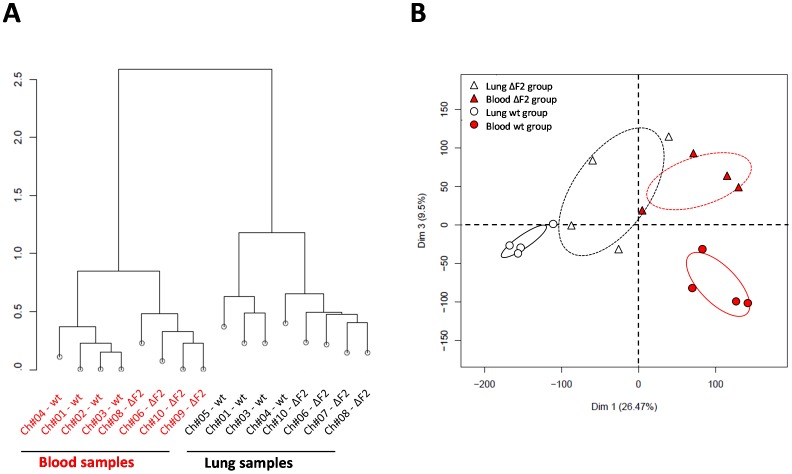
Correlation clustering and principal component analysis of microarray data.The expression value for each gene from lung and blood tissues of wt and ΔF2-infected chickens were used for the analysis. (A) The expression distance was measured between all pairs of arrays and represented as a tree. (B) The principal component analysis of the expression values was made to represent the variability between arrays. X-axis represents the first dimension (Dim 1, 26.47% of the variance) which separates the tissue samples (lung vs. blood), y-axis represent the third dimension (Dim 3, 9.5% of the variance) which separates the viral infections (wt vs. ΔF2). Clusters of samples on the PCA plot present a strong correlation of expression signals.